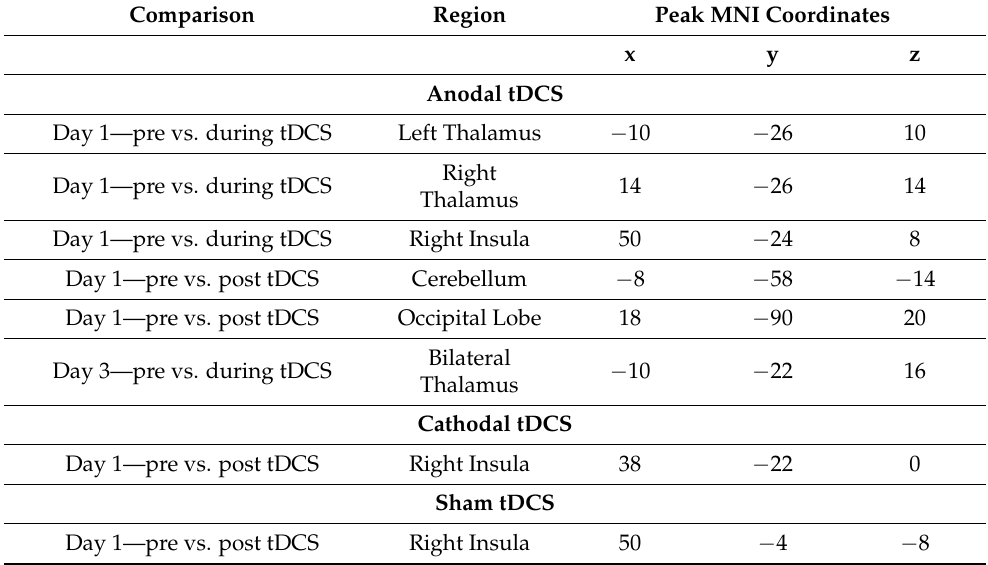
Table 1. ASL statistical analysis within the three group comparisons. The threshold was set at p < 0.05 and Z >